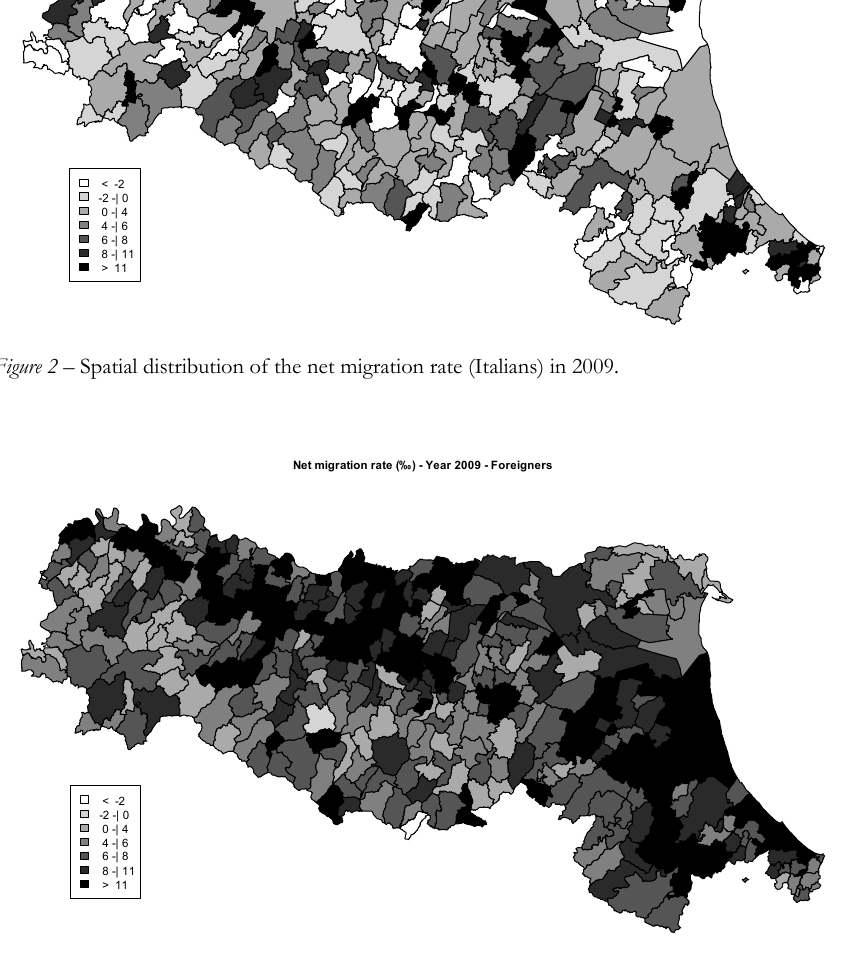
Figure 3 – Spatial distribution of the net migration rate (Foreigners) in